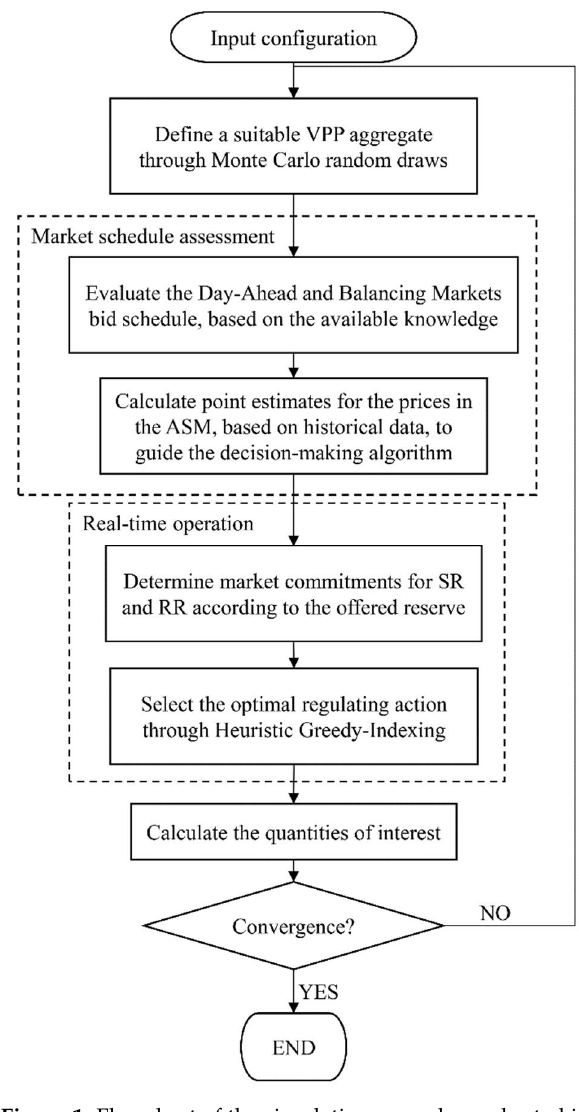
Figure 1. Flowchart of the simulation procedure adopted in the study.